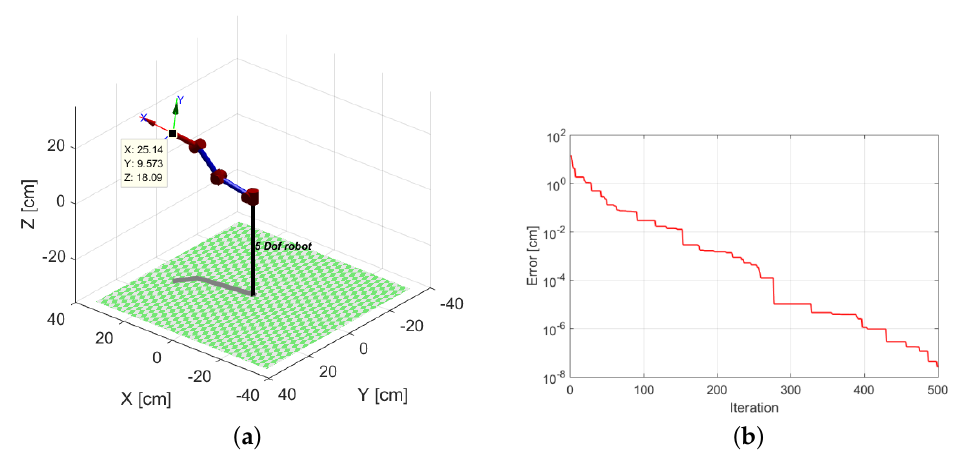
Figure 4. Mono-objective m-PSO for inverse kinematics: ( a ) 3D representation of the best solution using m-PSO, ( b ) m-PSO fitness evolution up to 500